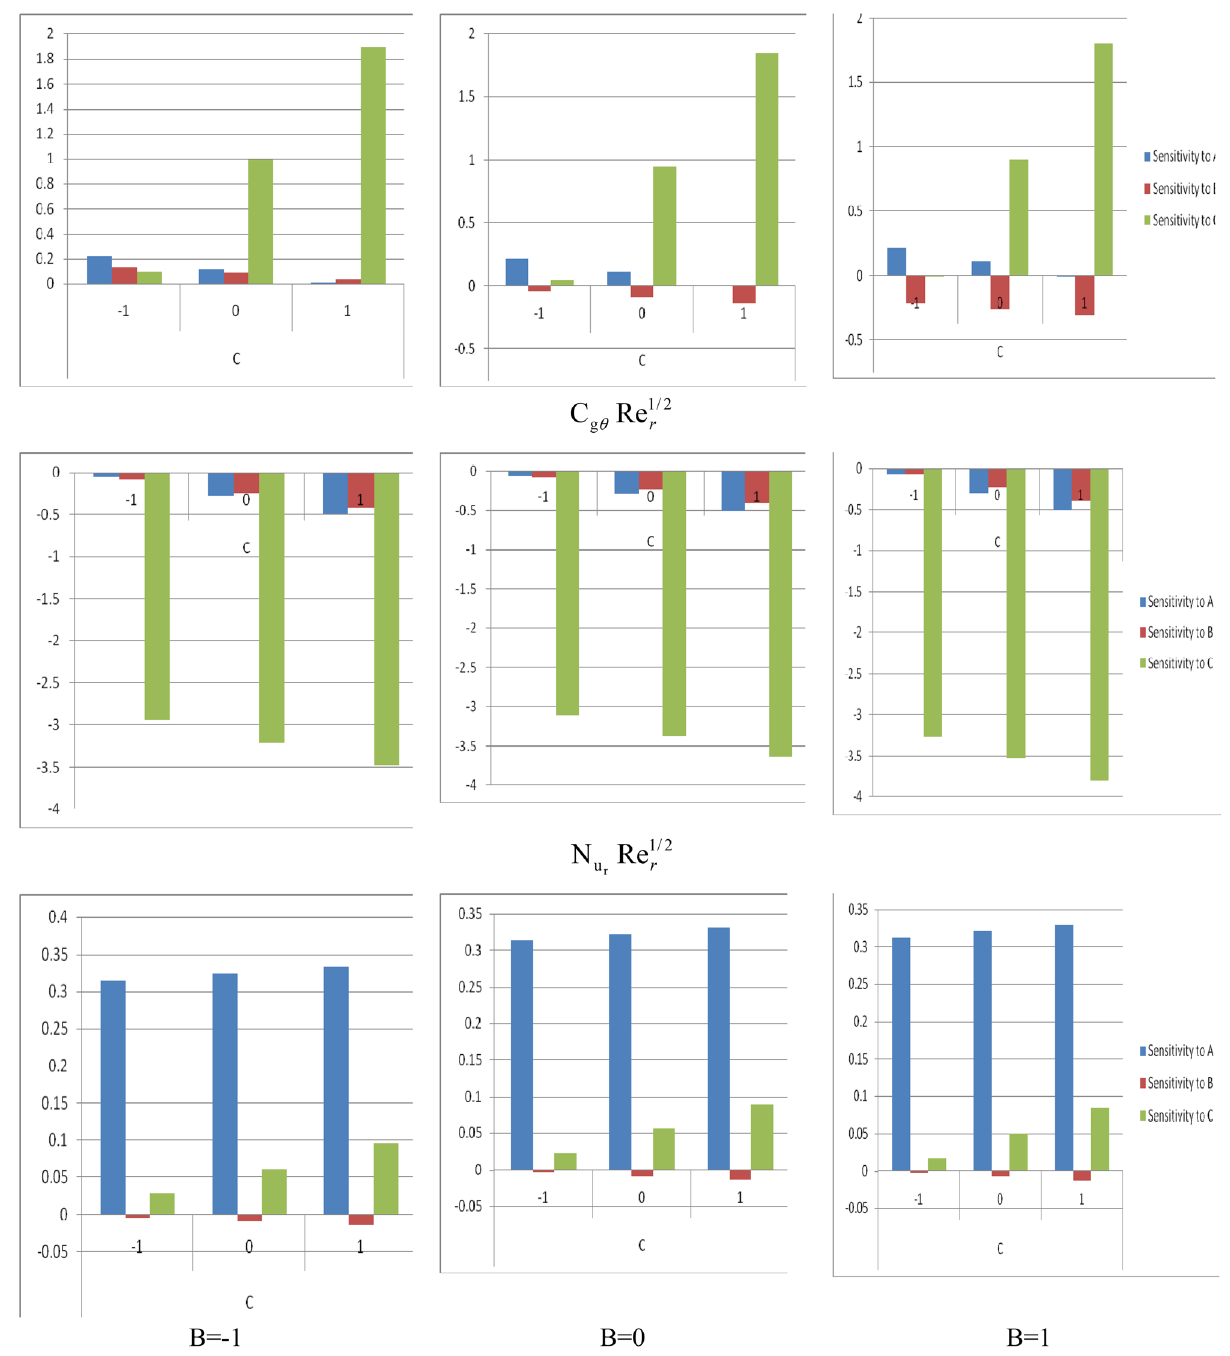
Figure 10. Sensitivity analysis with A = 0 and all combinations of Magnetic parameter and suction parameter 1 / 2 1 / 2 for skin friction coefficients C fr Re r is presented in the upper panel, for skin coefficient C g θ ∗ Re r is presented 1 / 2 in the middle panel and for the local Nusselt number Nu r Re − r is presented in the lower